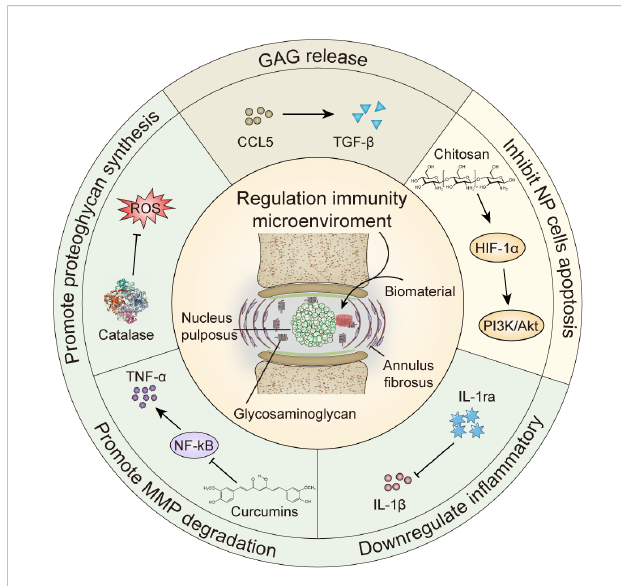
FIGURE 1 Biomaterials regulate cytokine repair of intervertebral disc degeneration. GAG, glycosaminoglycan; MMP, matrix metalloproteinase; HIF-1 a , hypoxia inducible factor-1 a ; IL-1ra, Interleukin -1 receptor antagonist; TNF, tumor necrosis factor; ROS, reactive oxygen species.